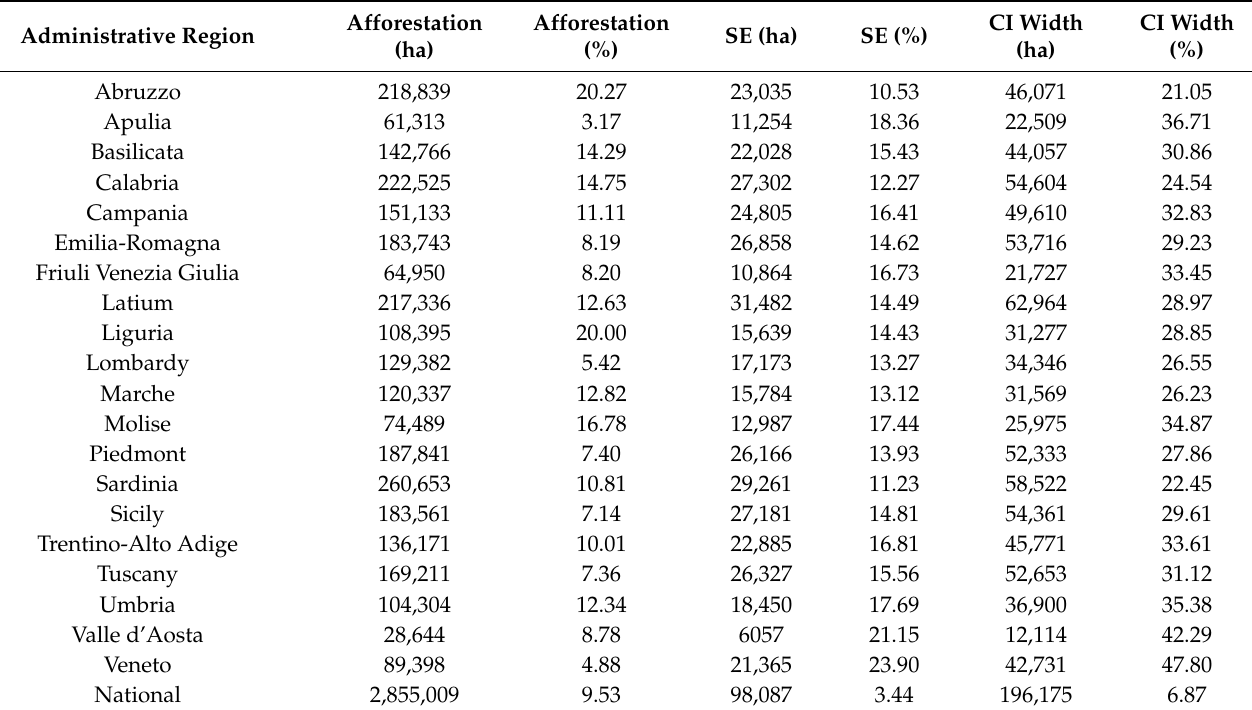
Table A3. Stratified area estimates for Italian administrative regions. This table shows the afforesta- tion estimates for each Italian administrative region in ha and percentage, with the associated standard error and 95% confidence interval